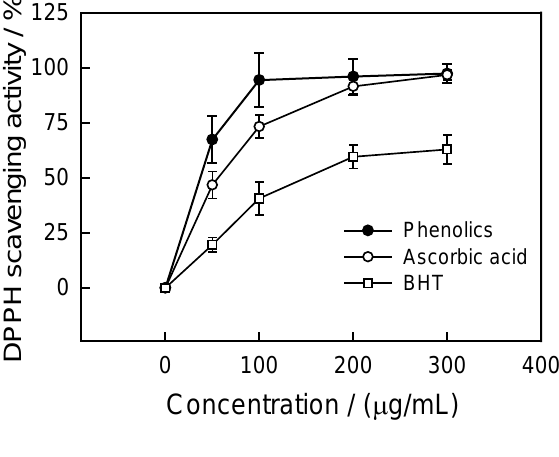
Figure 5 . Scavenging activity of phenolics from CWC tissues on DPPH radical.